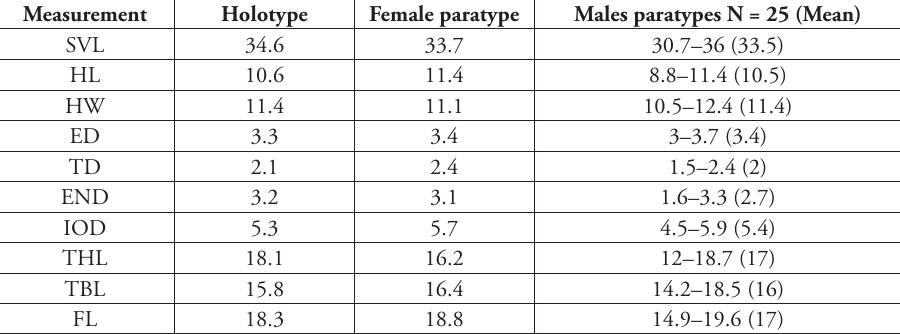
Table 2. Measurements (in millimeters) of the type-series of Aplastodiscus lutzorum sp. n. Abbreviations are: SVL (snout-vent length), HL (head length), HW (head width), ED (eye diameter), TD (tympa- num diameter), END (eye-nostril distance), IOD (interocular distance), THL (thigh length), TBL (tibia length), and FL (foot length).